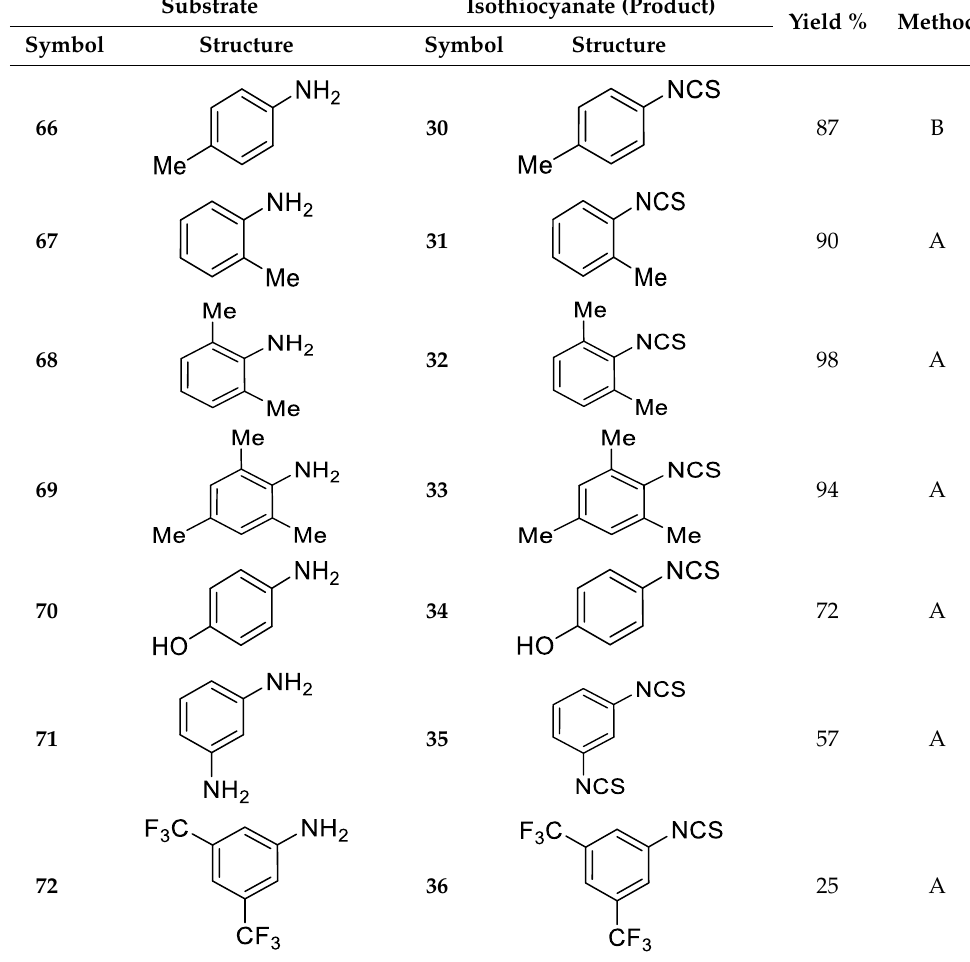
a Method A [96]; method B and method C [97]; method D [98].